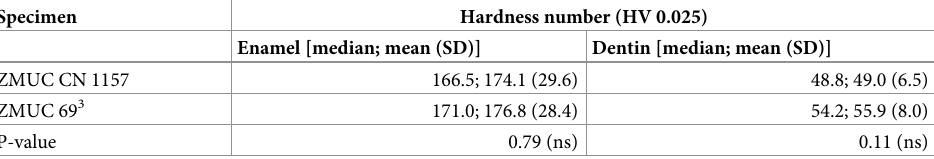
P-values are from Mann-Whitney U-tests; Eight measurements each in enamel and dentin per tooth; SD = standard deviation; ns = not